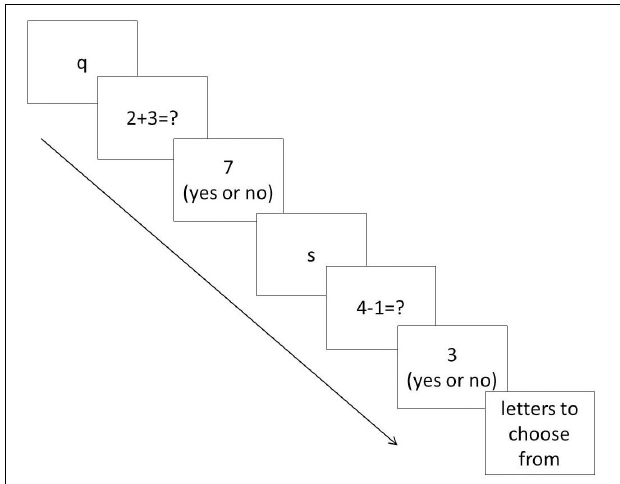
1 (“strongly disagree”) to 5 (“strongly agree”). The final score processing style and lower more verbal.